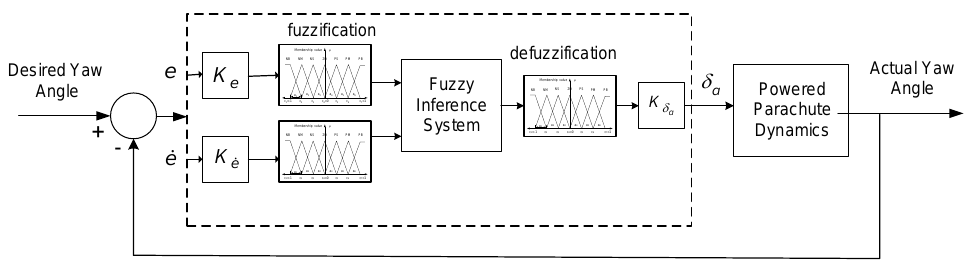
Figure 5. Structure of the PPC lateral FLC. Selecting the number and distribution of membership functions (MFs) for the inputs and outputs comprises the first steps in the FLC design. Seven normalized membership functions with triangular shapes were studied in this paper; see Figure 6 [8]. To describe these functions, the location of the vertices of the triangles must be determined. Only two parameters (a 1 and a 2 ) are needed for each variable.